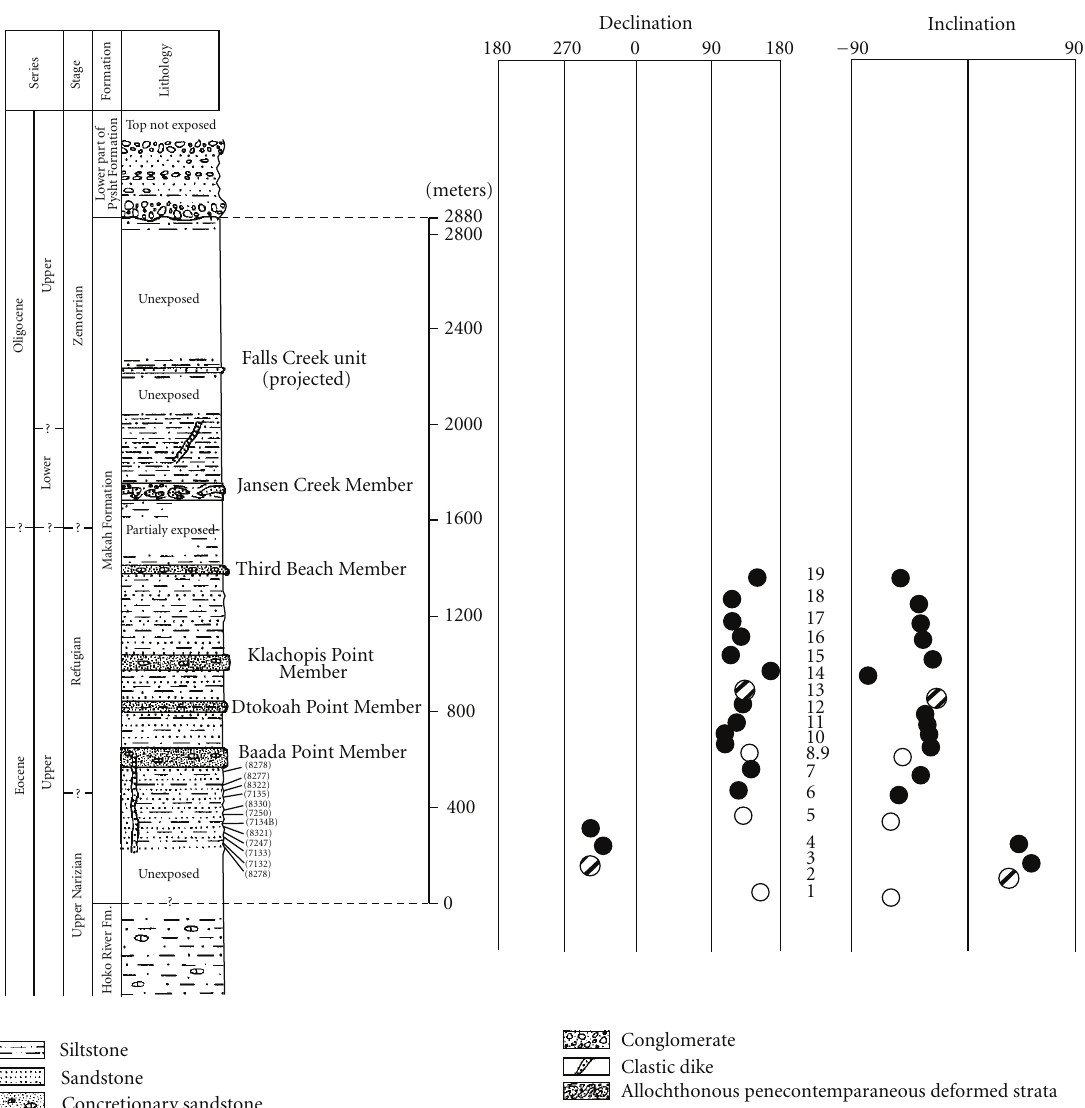
Figure 6: Magnetic stratigraphy of the type section of the Makah Formation at Baada Point. Solid circles are Class I sites of Opdyke et al. [55], which have three or more sample directions that are statistically removed from a random distribution at the 95% confidence level. Hachured circles are Class II sites of Opdyke et al. [55], which had only 2 samples that survived sampling and transport, so no statistics could be calculated. Open circles are Class III sites of Opdyke et al. [55], where two directions show a clear polarity preference, but the third sample direction is divergent. Stratigraphy modified from Snavely et al. [8, Figure 4].